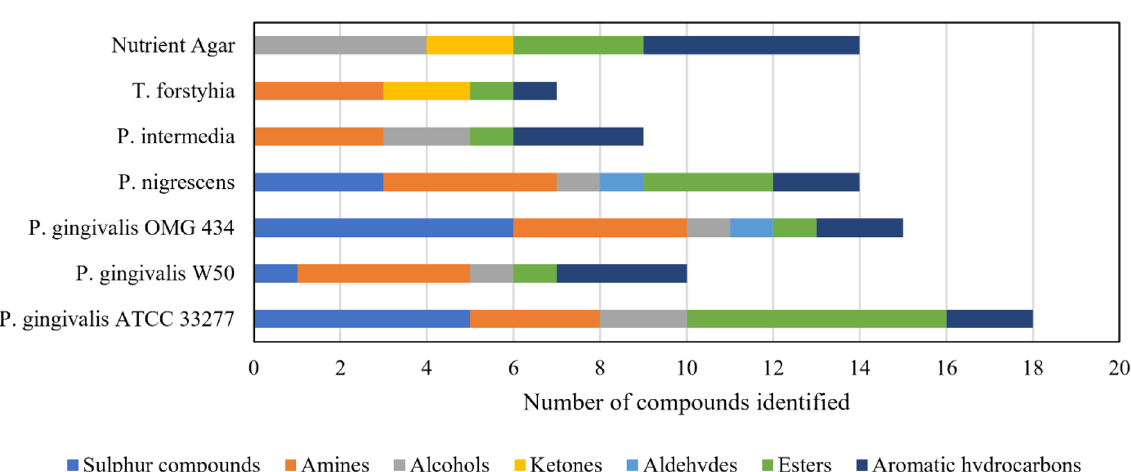
Figure 3. Volatile fingerprints of the studied oral bacteria by compound group. Some of the compounds produced by the bacteria are also produced by the nutrient agar, and for clarity, these compounds are excluded from this figure. Only compounds produced solely by the bacteria are